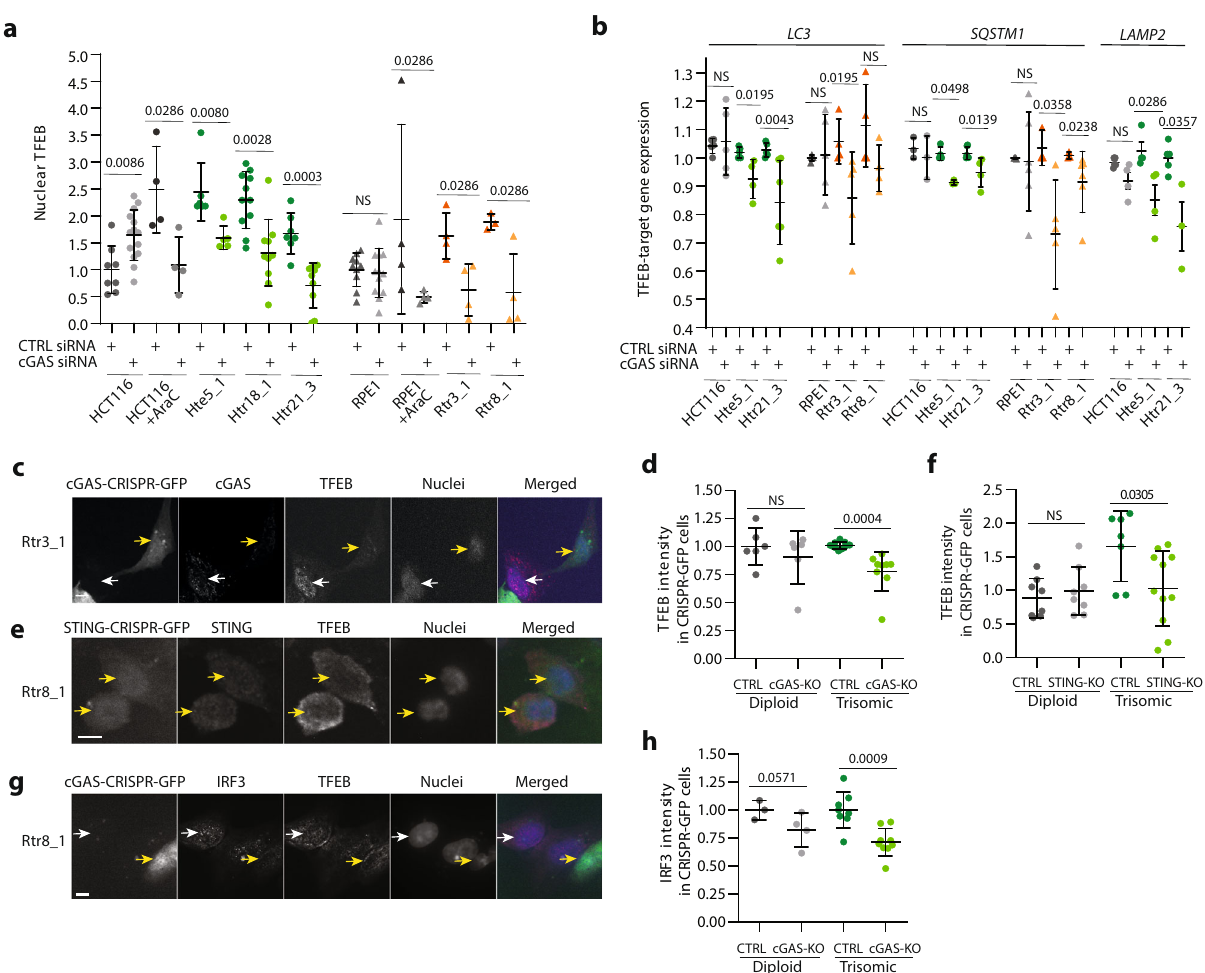
Fig. 5 The activation of autophagy in constitutive trisomic cells depends on cGAS. a Quanti fi cation of TFEB nuclear localization upon cGAS siRNA treatment. The nuclear TFEB was quanti fi ed from delta MFI similarly as in Fig. 1f and plotted relative to CTRL siRNA for every cell line. In total, 3 – 14 independent experiments were performed in each cell line. b qRT-PCR data of selected TFEB target genes after cGAS depletion with siRNA. Relative LC3, SQSTM1 , and LAMP2 levels were calculated using endogenous controls RPL27 and SPIKE. The data were plotted after normalization to the corresponding control siRNA sample for each cell line. In total, 3 – 6 independent experiments were performed for each cell line. c , e , g Examples of immuno fl uorescence images of TFEB localization upon cGAS or STING knockout with CRISPR/Cas9 nickase. Yellow arrow marks the cells ef fi ciently transfected with the CRISPR – CAS9 – GFP RNP that lack either nuclear TFEB ( c , e ) or IRF3 ( g ). White arrow marks the untransfected cells with normal nuclear expression of cGAS, IRF3, and TFEB. Scale bar 10 µ m. d , f , h Quanti fi cation of the MFI of TFEB ( d , f ) and IRF3 ( h ) signals in cGAS or STING knockout cells transfected with CRISPR – CAS9 – GFP. The data are presented in comparison with cells transfected with control CRISPR – CAS9 – GFP. Both HCT116 and RPE1 diploid and all aneuploid cell lines were grouped together. About 4 – 11 measurements were performed in each sample group. Mann – Whitney test was applied for the statistical analysis of the graphs a and b , unpaired t -test was used for the graphs d , f , h . Individual measurements, mean values, p value, and standard deviations are shown in the plots, statistical evaluation is summarized in Supplementary table 4; source data is available in Supplementary Data